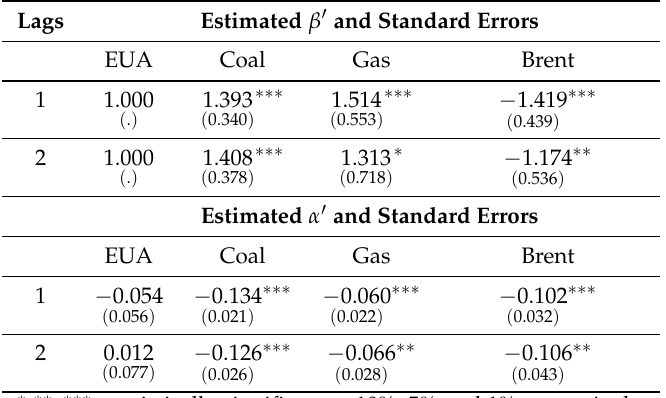
Table 8. Estimated coefficients in Equation (1) for the long- and short-run relationship ( β and α , respectively) of the monthly forward price series.